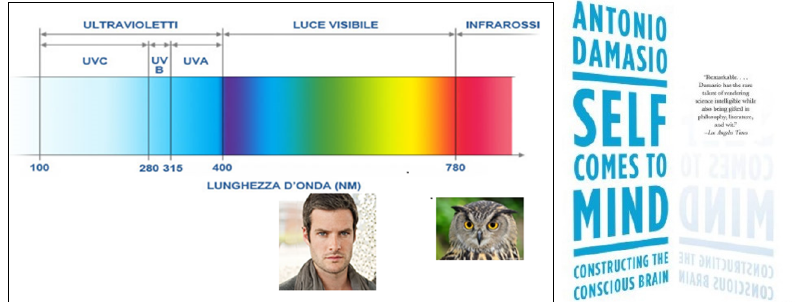
Figure 8. Intuitive representation of the “active mirroring” brain–environment in cognitive neuro- science, consistent with Damasio’s biological foundation of intentionality on the physical homeostasis principle—as suggested metaphorically in the promotional picture of Damasio’s book on the right—that holds in biology, from the epigenetic principle of cell specialization, till brains and beyond (see text).